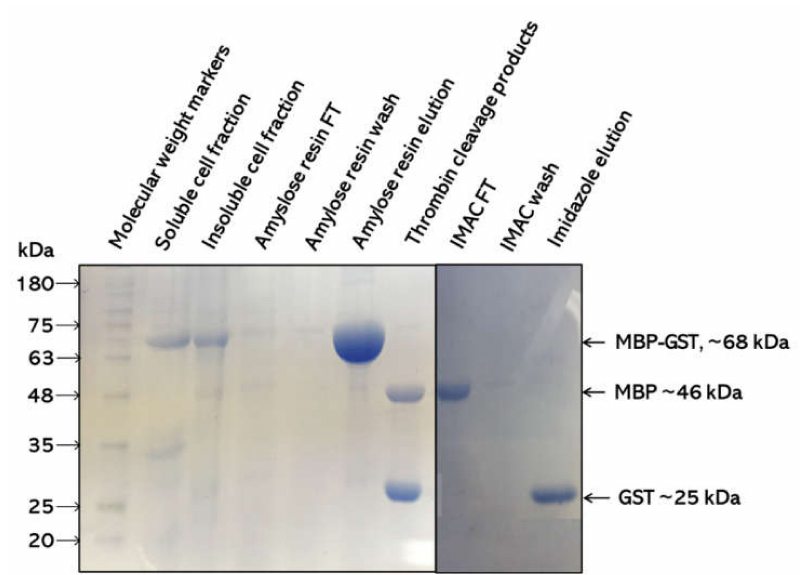
Figure 2. SDS–PAGE analysis of Sbh26GST over-expression and purification. Cell lysate rom the IPTG induction was separated into the insoluble pellet and soluble supernatant fractions. The supernatant was further subjected to an amylose resin column that binds maltose-binding protein (MBP). The flow-through (FT) had unbound protein, and weakly bound proteins were removed via several washes before elution with maltose. The recovered protein was cleaved with thrombin and purified with